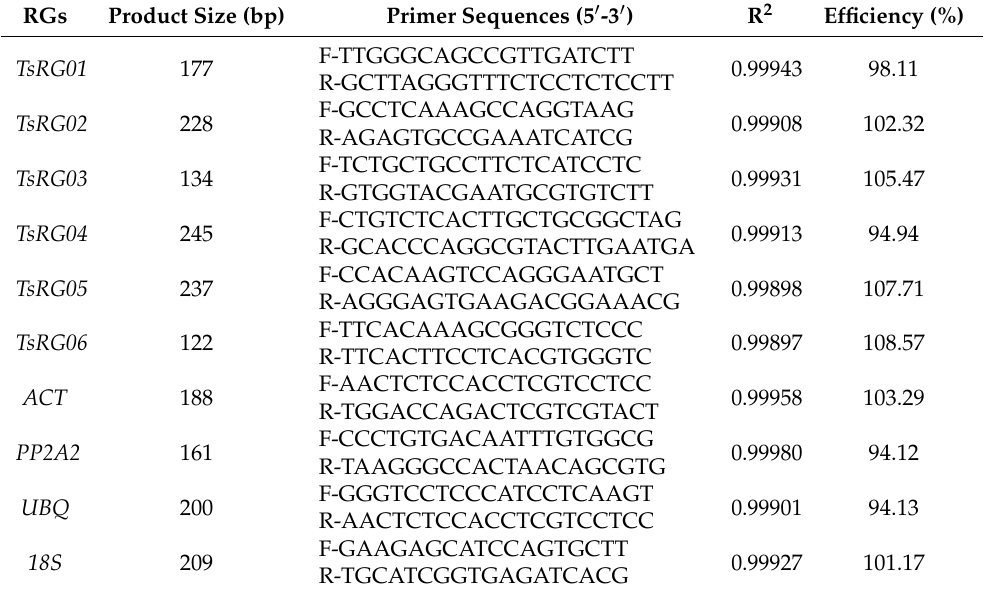
Table 1. Primers of candidate